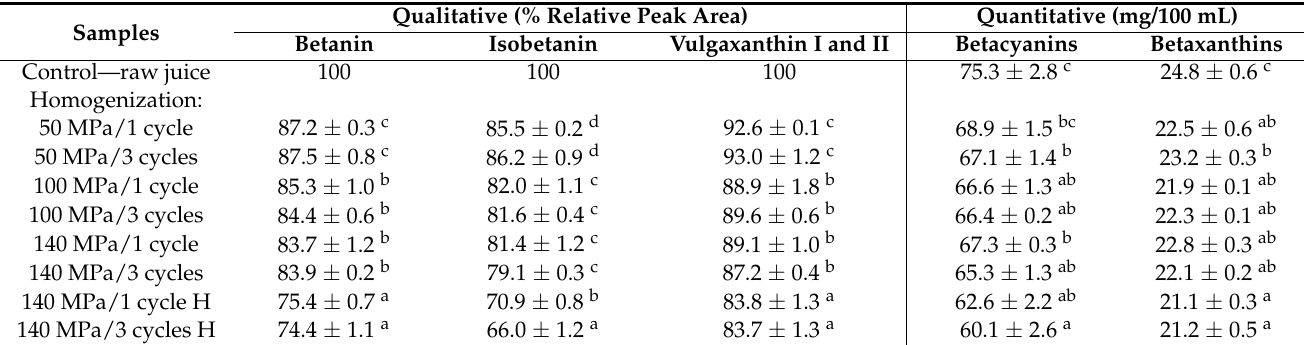
Table 4. Betalain stability in beetroot juice samples treated with